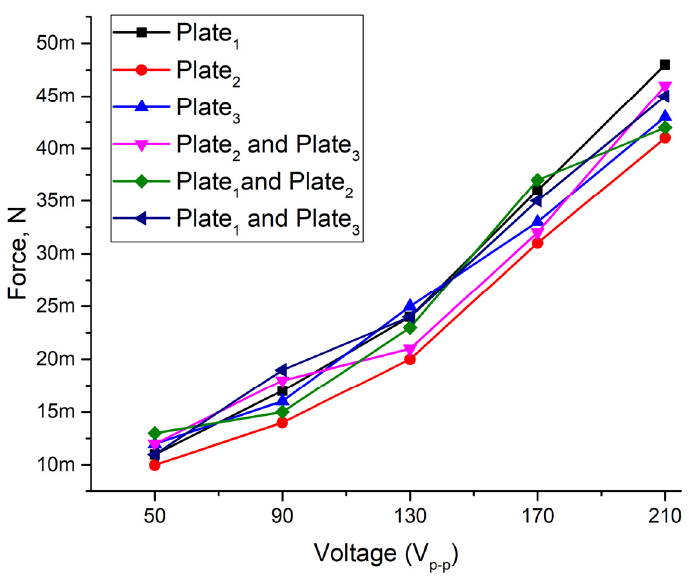
Figure 18. Output force characteristics at different excitation voltages while 32.17 g load was applied to the platform.